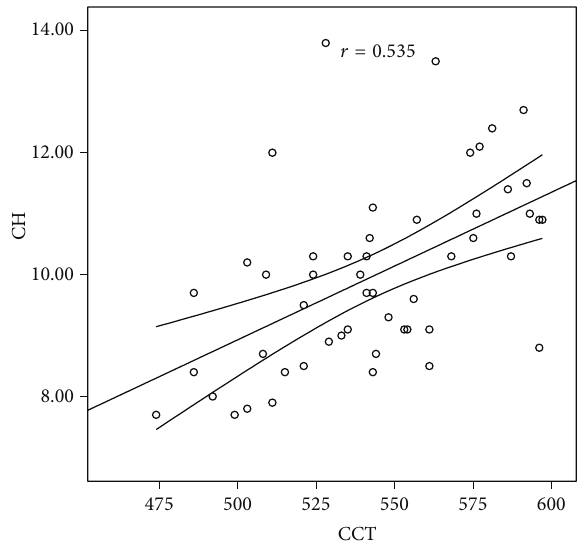
Figure 2: Correlation graphic between CRF and CCT. CRF: corneal resistance factor, CCT: central corneal